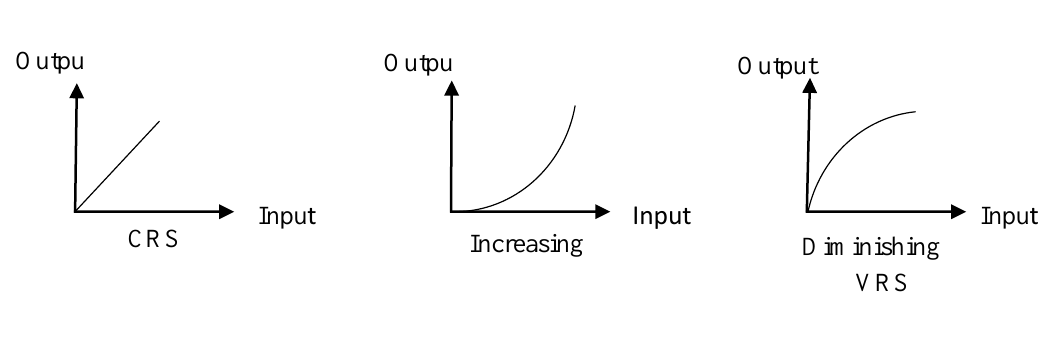
Figure 3. Diagram of Different Kinds of Return to